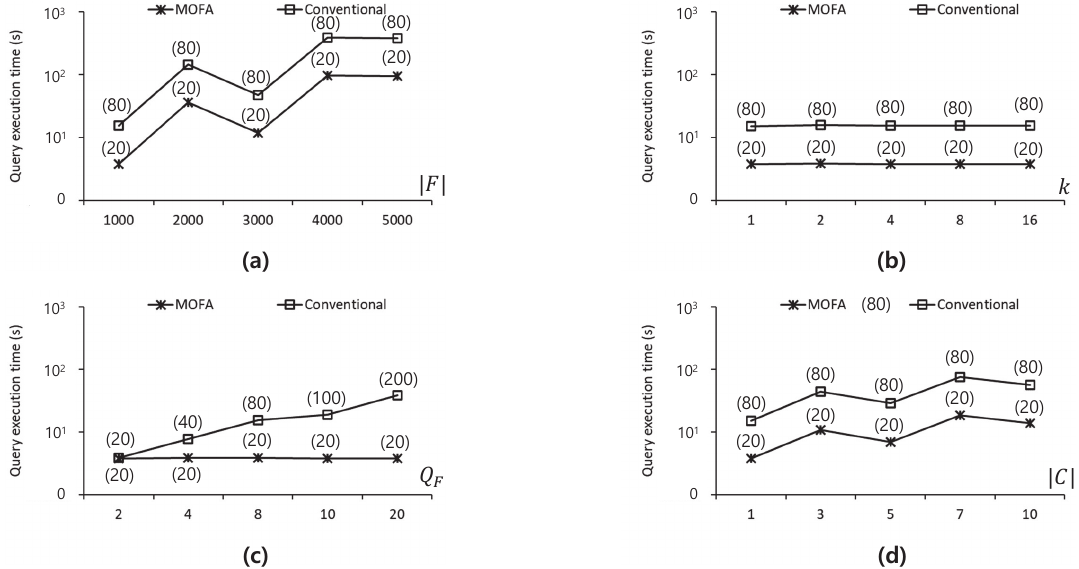
Figure 14. Performance comparisons between MOFA and the conventional algorithm on the SJ